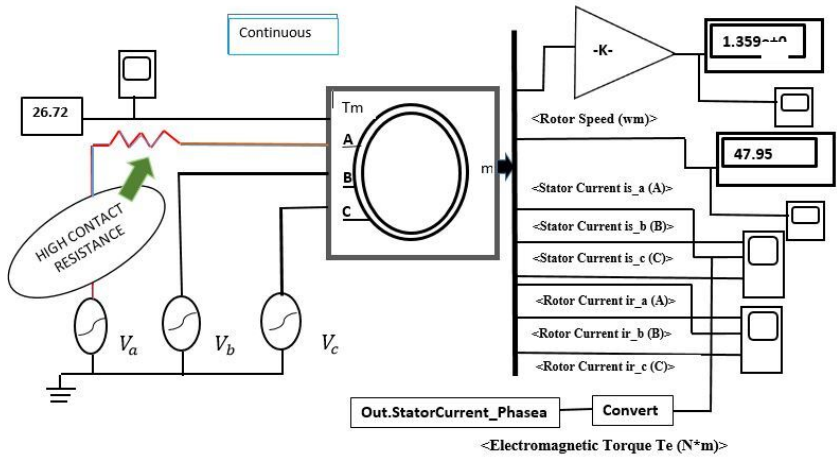
Figure 1. High contact resistance (HCR) fault in a MATLAB Simulink environment. A–C shows stator phases.